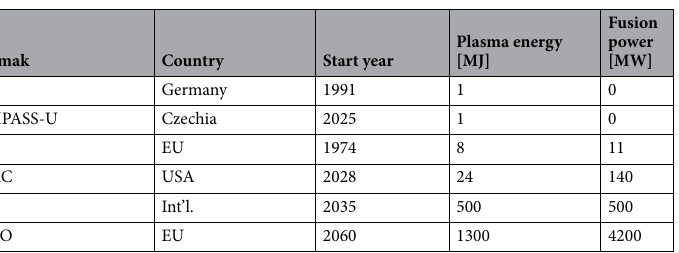
Table 1. Overview of mentioned tokamaks. At top: copper coils limit discharges to less than 10 s. At bottom are superconductive tokamaks with much longer operation. Energy released within regular ELMs is a few % of 0 2.5 the plasma energy at frequency 10 −